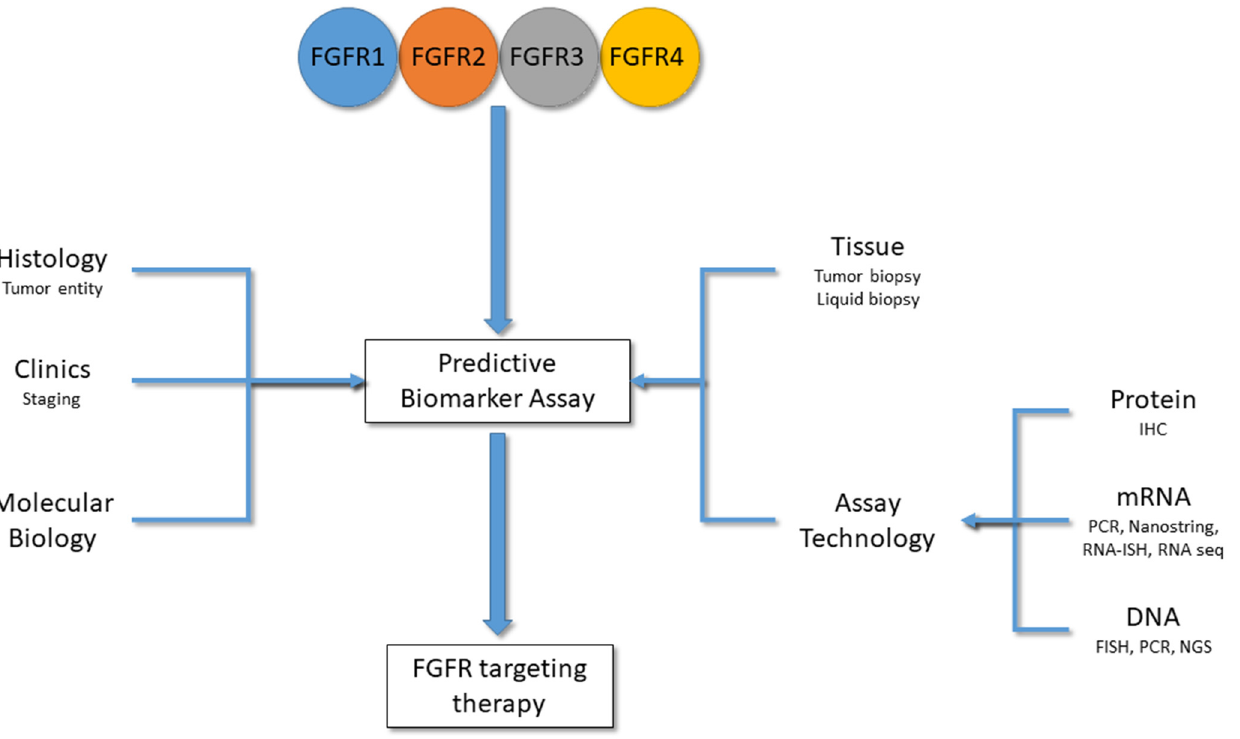
Figure 3. Factors influencing the selection of a predictive biomarker assay for FGFR-inhibitor therapies. Alterations in FGFR1-4 impact on the predictivity of a biomarker assay. In addition to the molecular biology of the alterations (CNV, fusion, mutation, etc.), also, the underlying tumor entity (histology), the clinical staging (e.g., muscle-invasive vs. non-muscle-invasive bladder cancer), tissue availability and the assay technology with different target readouts (protein, mRNA, DNA) determine which FGFR targeting therapy would bring benefit to a patient.